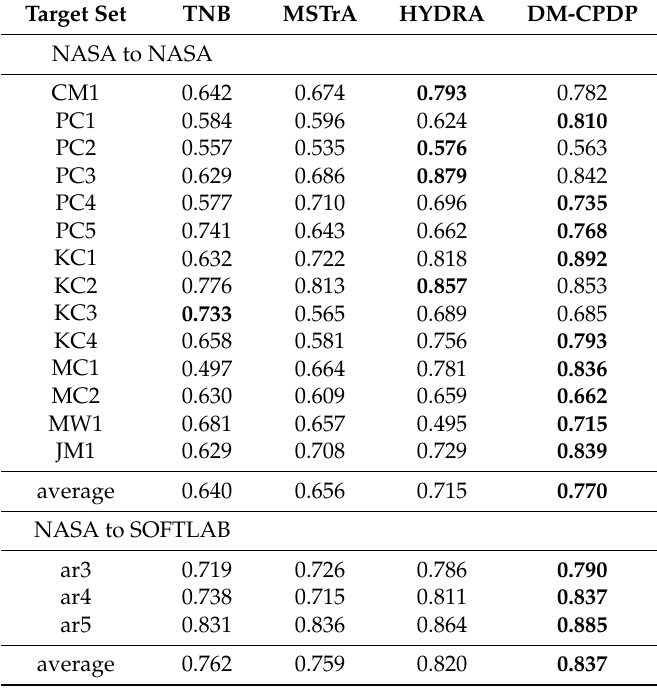
Table 5. Comparison of performance indicators AUC.